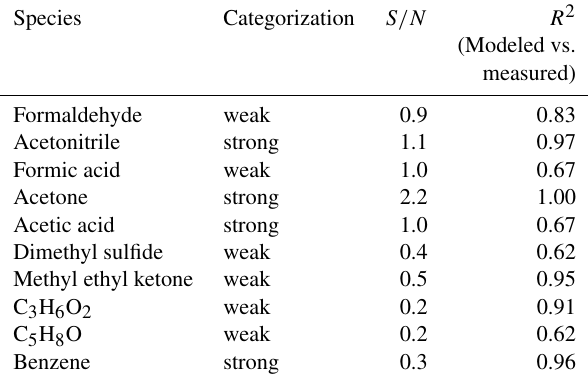
Table 2. Input species for the PMF model along with species cate- gorization, S/N , and R 2 values for modeled vs. measured